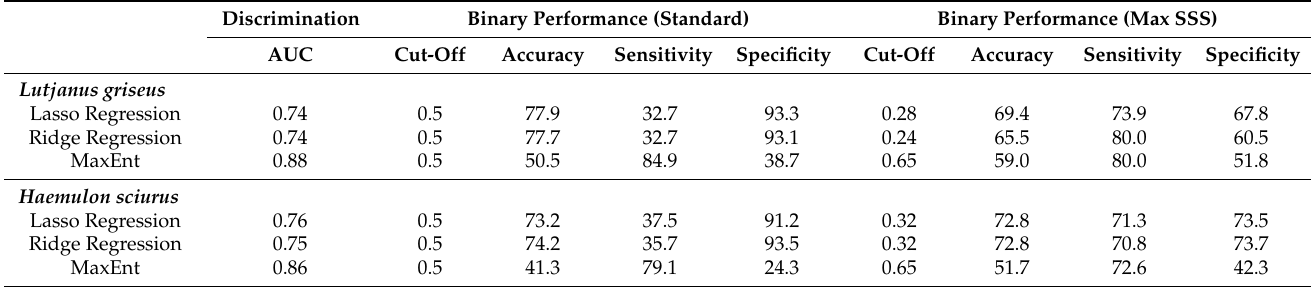
Haemulon sciurus Lasso